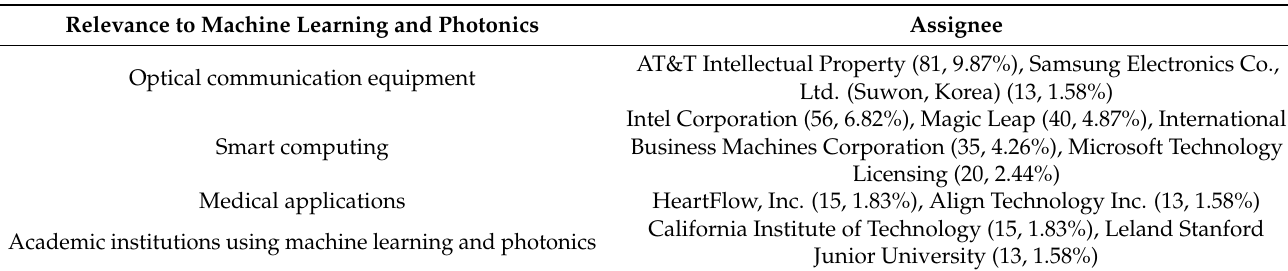
Table 2. Number of granted patents of the top ten